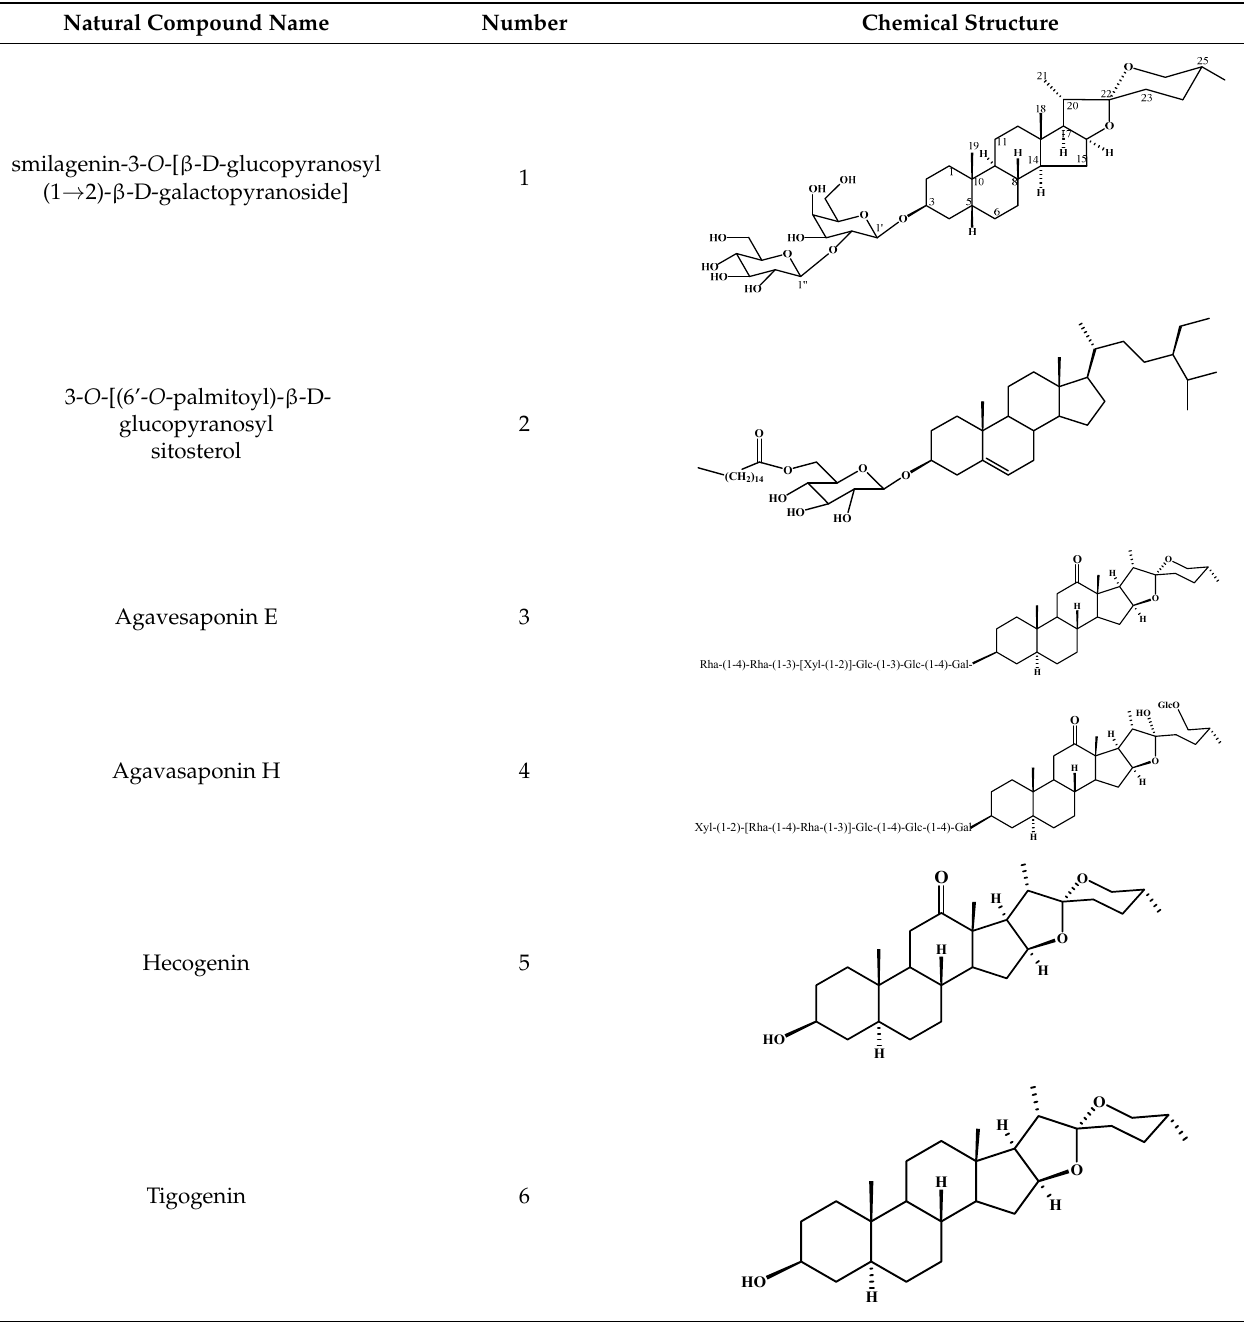
Table 2. Chemical structures of compounds with anti-inflammatory activity contained in Agave spe- cies.